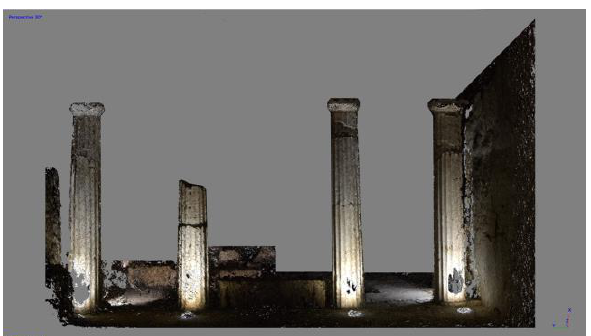
Figure 14. The Tomb of Persephores in Verghina. Cloud of points.